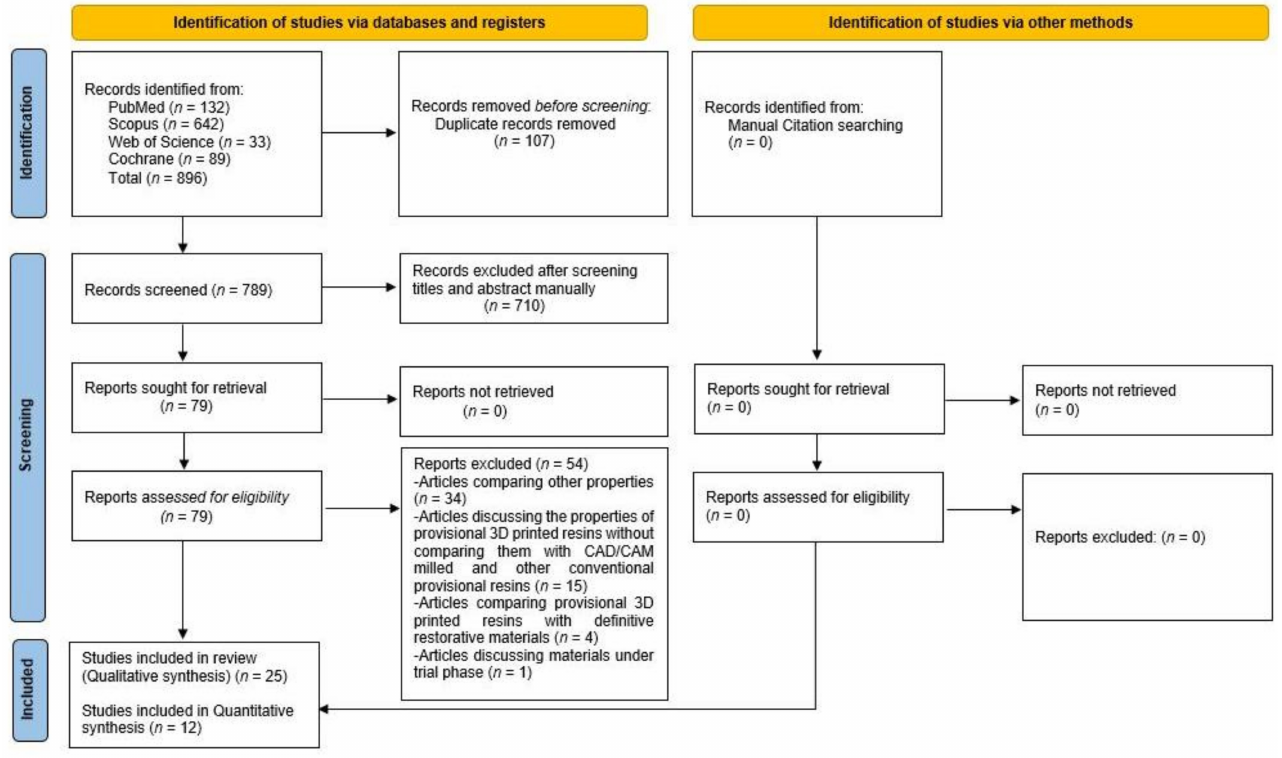
Figure 1. Article selection strategy based on PRISMA